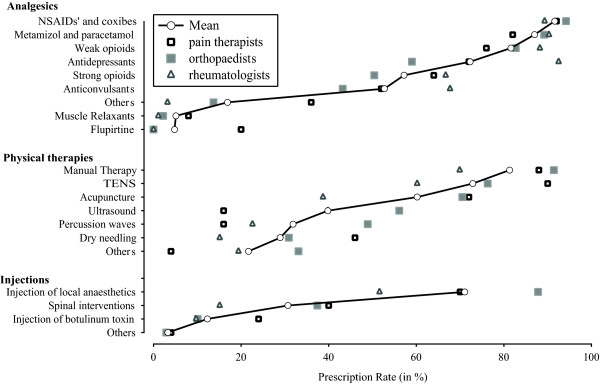
Prescription Rate. demonstrates the physician estimated prescription rate of different therapeutic options in the treatment of myofascial pain. Circles indicate the overall average; the prescription rates of three subgroups (Pain therapists, rheumatologists and orthopaedists) are shown by triangles or squares (please refer to legend). Data are expressed in percent (%). TENS: transcutaneous electrical stimulation.